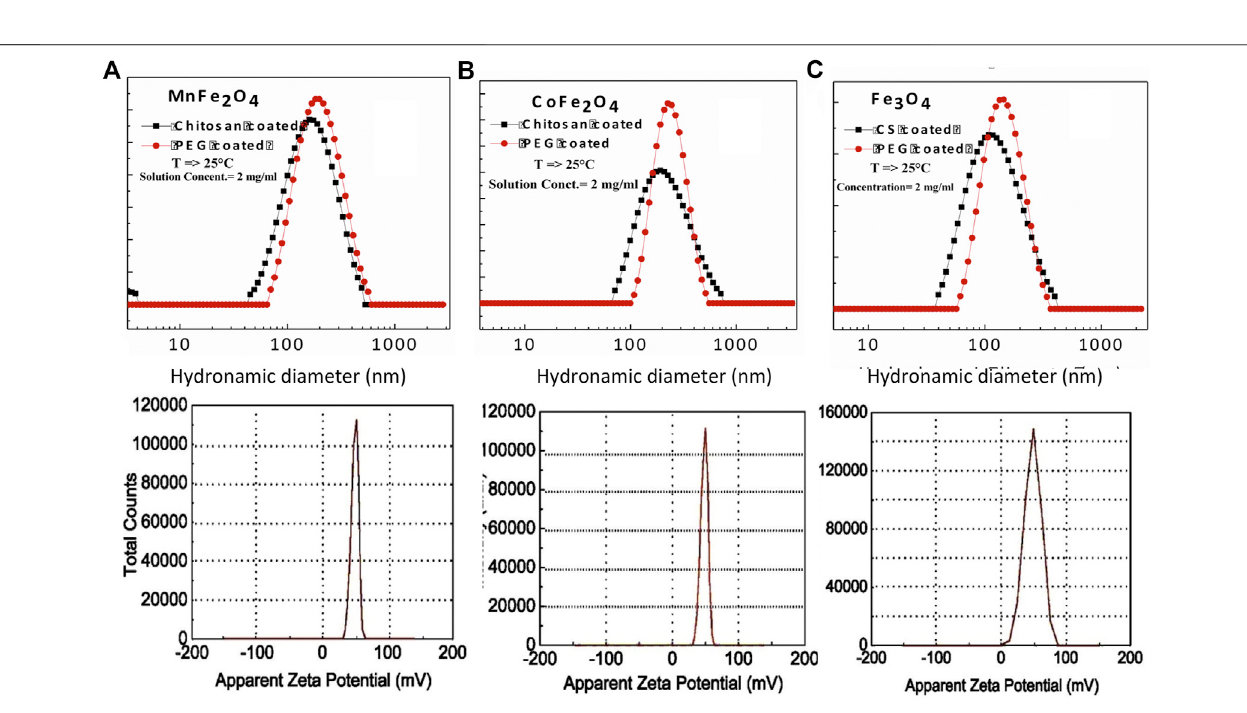
Frontiers in Nanotechnology |